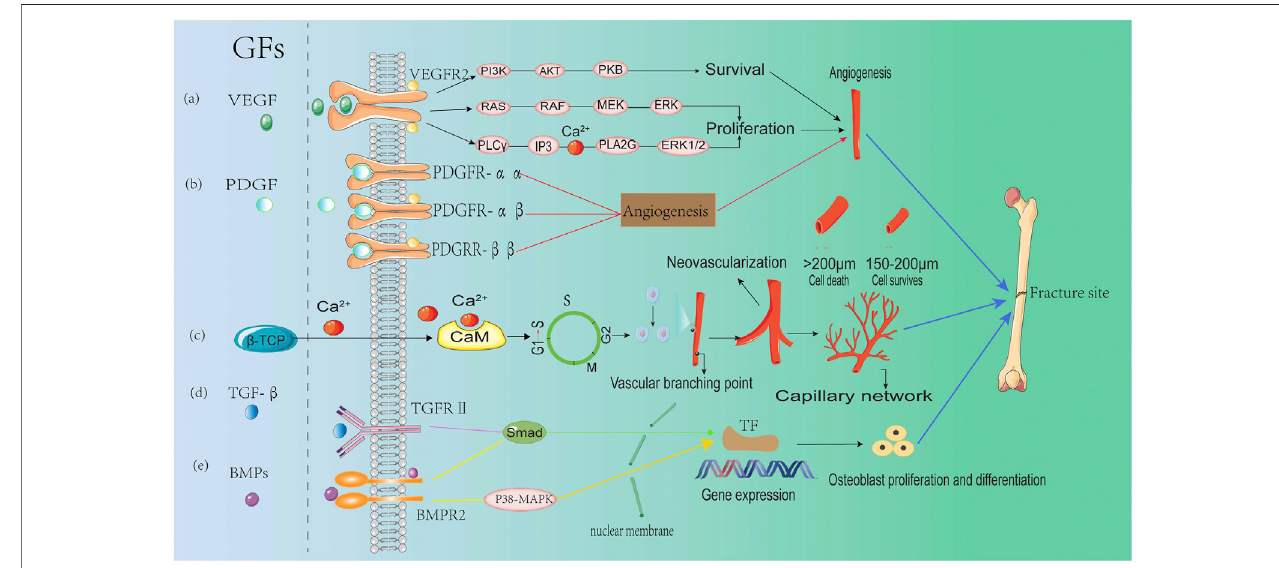
FIGURE 3 | The role of growth factors in regulating angiogenesis during bone formation (A) Vascular endothelial growth factor (VEGF) regulates osteogenesis through three major signaling pathways after binding to VEGFR2: the PI3K/AKT pathway, the Raf-MEK-ERK pathway and the PLC γ -IP3 pathway. (B) Platelet derived growth factor (PDGF) regulates angiogenesis by binding to and activating PDGFR- αα , PDGFR- αβ , and PDGFR- ββ receptors. (C) Ca 2 released from β -TCP, binds to calmodulin (CaM) to promote cell cycle progression (G1 → S), enhancing endothelial cell proliferation and facilitating neovascularization and bone healing. (D) Transforminggrowthfactorbeta(TGF- β )inducesup-regulationofosteogenicgeneexpressionthroughtheSMADsignalingpathwayafterbindingtotransforminggrowth factor beta receptor2 (TGFR2). (E) Bone morphogenetic proteins (BMPs) facilitate the expression of osteogenic genes via bone morphogenetic protein receptor type-2 (BMPR) and the activation of SMAD and p38-MAPK signaling